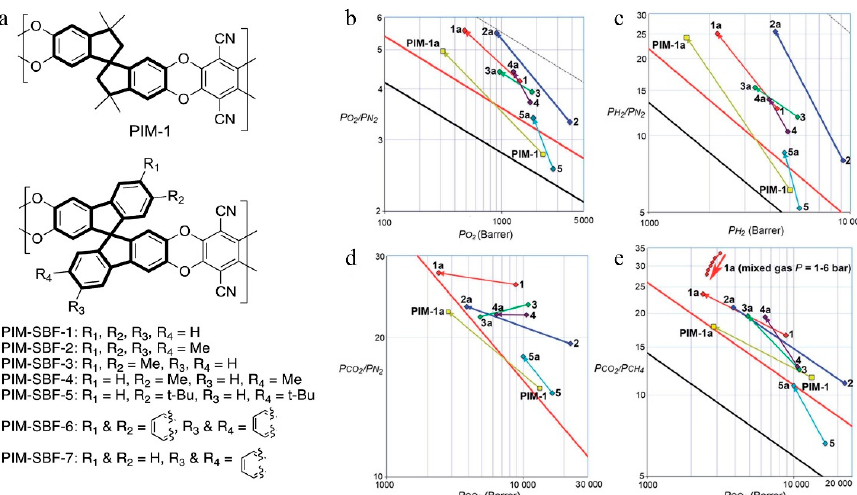
Figure 4. The structures of the spirobisindane-based PIM-1 and the spirobifluorene-based PIM-SBF series ( a ), Robeson plots for the ( b ) O 2 /N 2 , ( c ) H 2 /N 2 , ( d ) CO 2 /N 2 , and ( e ) CO 2 /CH 4 gas pairs showing the position of the gas permeability data for PIM-SBFs 1–5 and that of PIM-1. Data from films aged for >3.5 years (e.g., 2a) are joined by an arrow to those of the freshly methanol treated films to form aging trend-lines. Upper bounds are represented by black (1991), red (2008), and dotted (2015) lines. Mixed CO 2 /CH 4 data at pressures of 1–6 bar for the film of PIM-SBF-1 aged for 2088 days are also plotted with a red arrow, which indicates increasing pressure. Adapted from Reference [50].